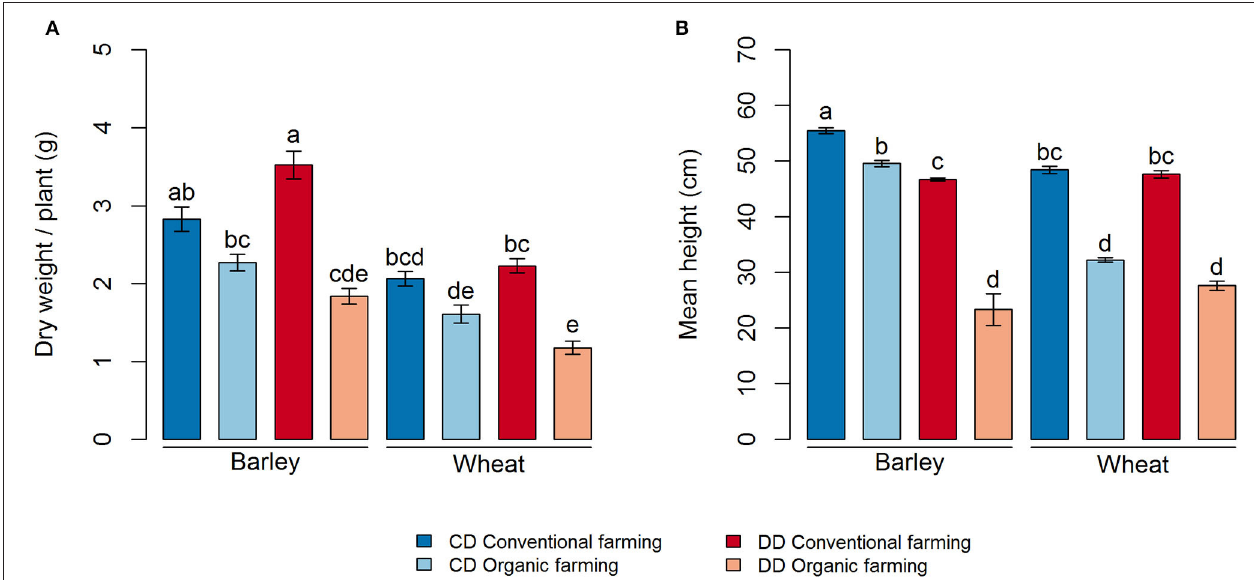
FIGURE 2 | Plant growth measures for each treatment, (A) dry weight per plant and (B) mean height. Values correspond to the average, and error bars to the respective standard error, of five pot, replicates. Letters show the statistical differences between treatments according to the Kruskal–Wallis test followed by Fisher’s